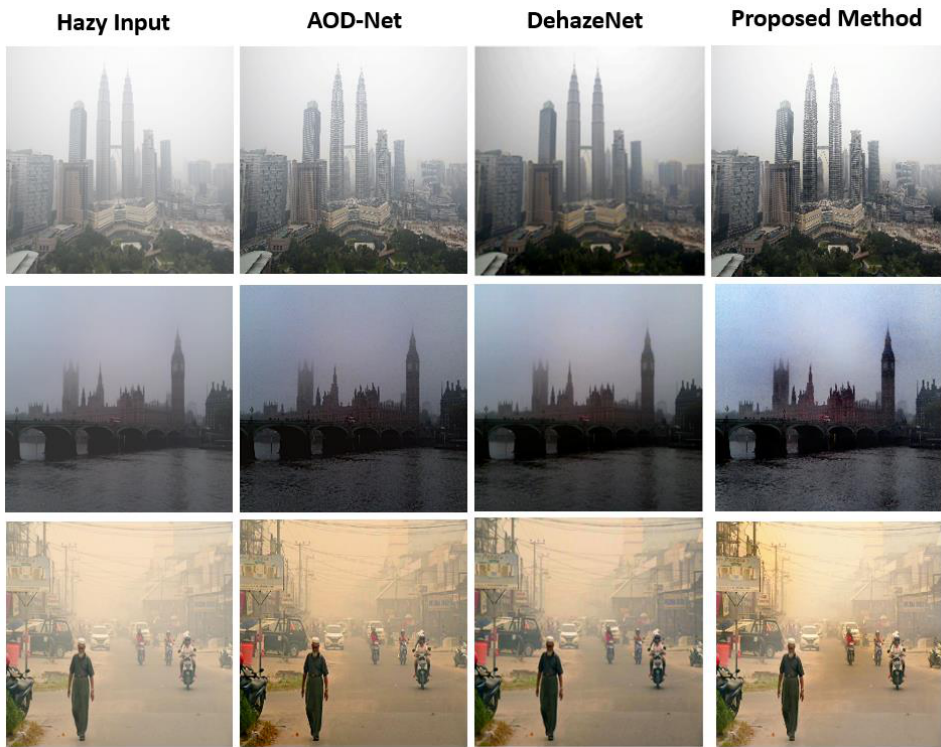
Figure 12. Comparison of dehazing results of real hazy image.